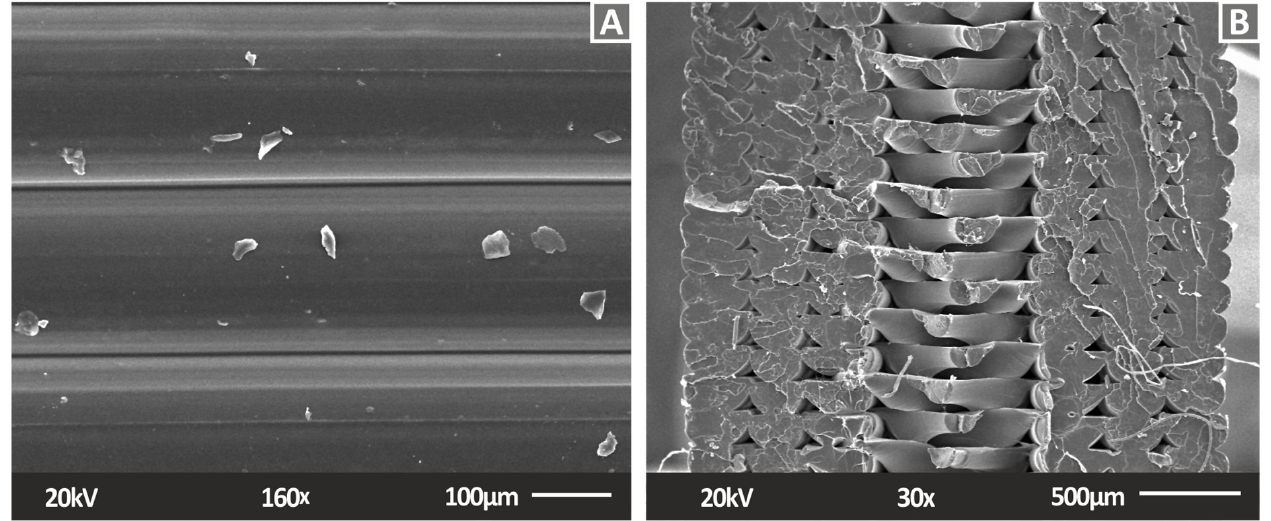
Figure 11. SEM images for the pure PLA material 3D-printed tensile specimen: ( A ) side of the specimen, ( B ) fracture surface.